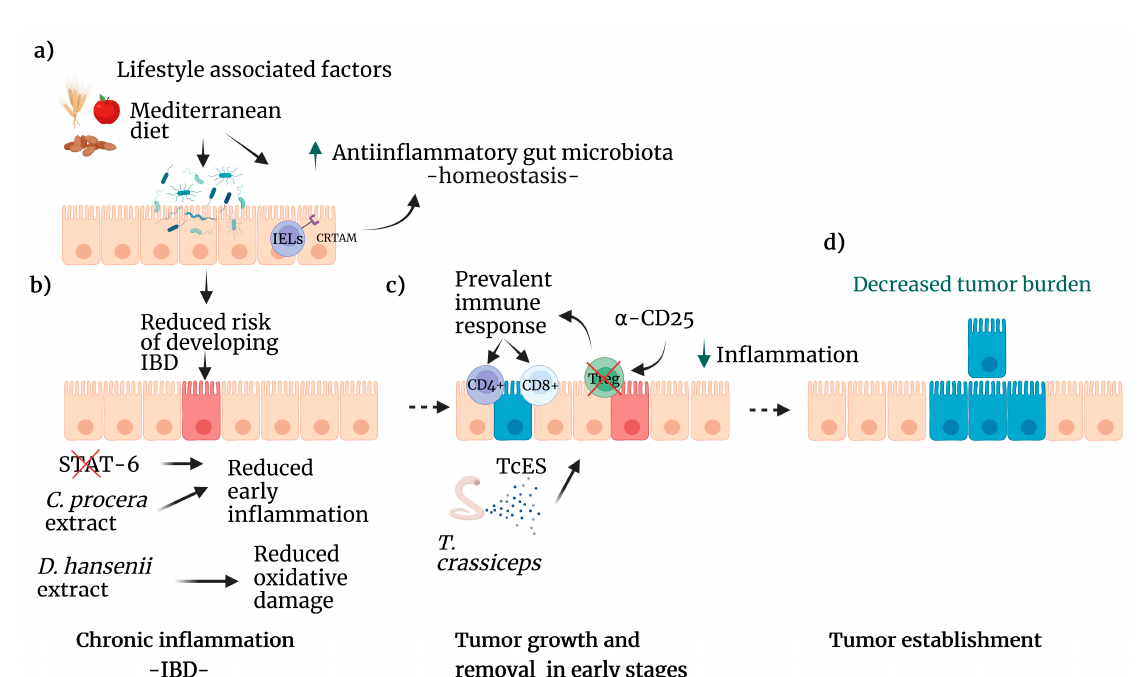
Figure 3. Lifestyle factors that reduce the risk of CRC. ( a ) Diets that include fruits, seeds, and whole grains as the Mediterranean diet improve the gut microbiota, increasing the population of anti-inflammatory bacteria (green arrow). CRTAM, an IELS receptor, is vital in maintaining homeostasis in the colon. This healthy microbiome reduces the risk of IBD. ( b ) Several natural compounds, such as C. procera extracts or STAT6 inhibitors, can reduce inflammation caused by IBD. D. hansenii extract diminishes oxidative damage caused by colitis. ( c ) Treg inhibition enhances the immune system response by T cell lymphocytes, and T. crassiceps excreted-secreted products modulate several pathways leading to decreased inflammation (green arrow). ( d ) As a result, tumor development decreases. Created with BioRender.com, accessed on 27 June